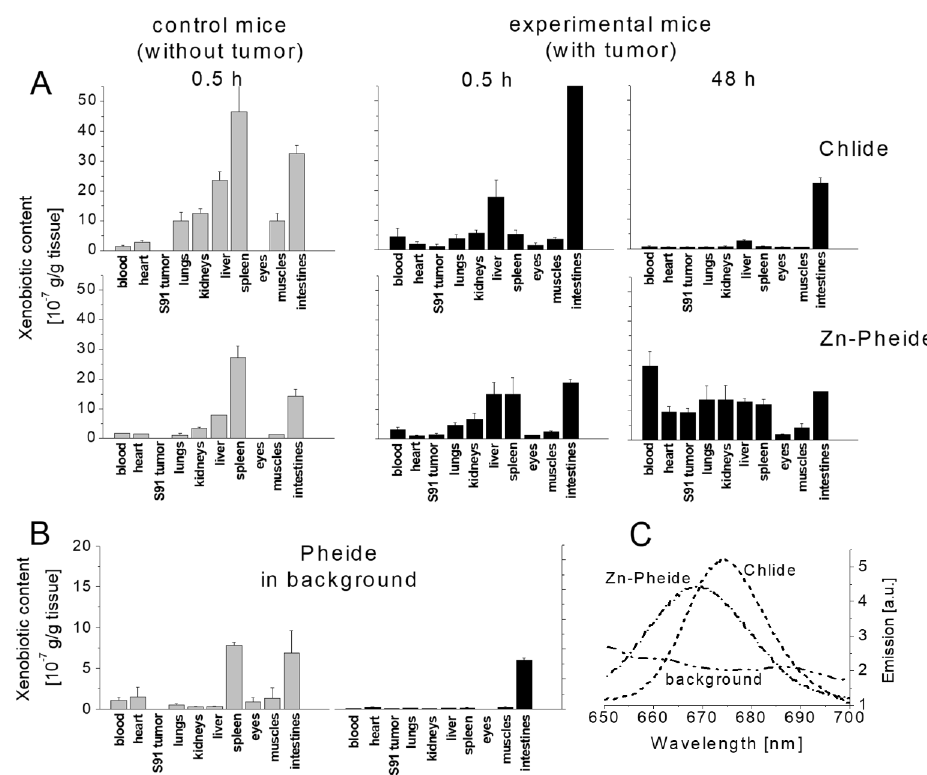
Figure 4. The pharmacokinetics of model xenobiotics, Chlide and Zn-Pheide, in DBA/2 mice: ( A ) analysis was carried out in healthy (gray bars) and large melanoma S91 tumor-bearing (black bars) animals 0.5 h and 48 h after their i.p. administration (each at 10 mg/kg body weight); ( B ) the content of the endogenous Pheide in tissues of the untreated mice. The values represent mean concentration with SE; and ( C ) in vivo transdermal recording of Chlide and Zn-Chlide emission in tumors after their i.p. administration (see the text for the